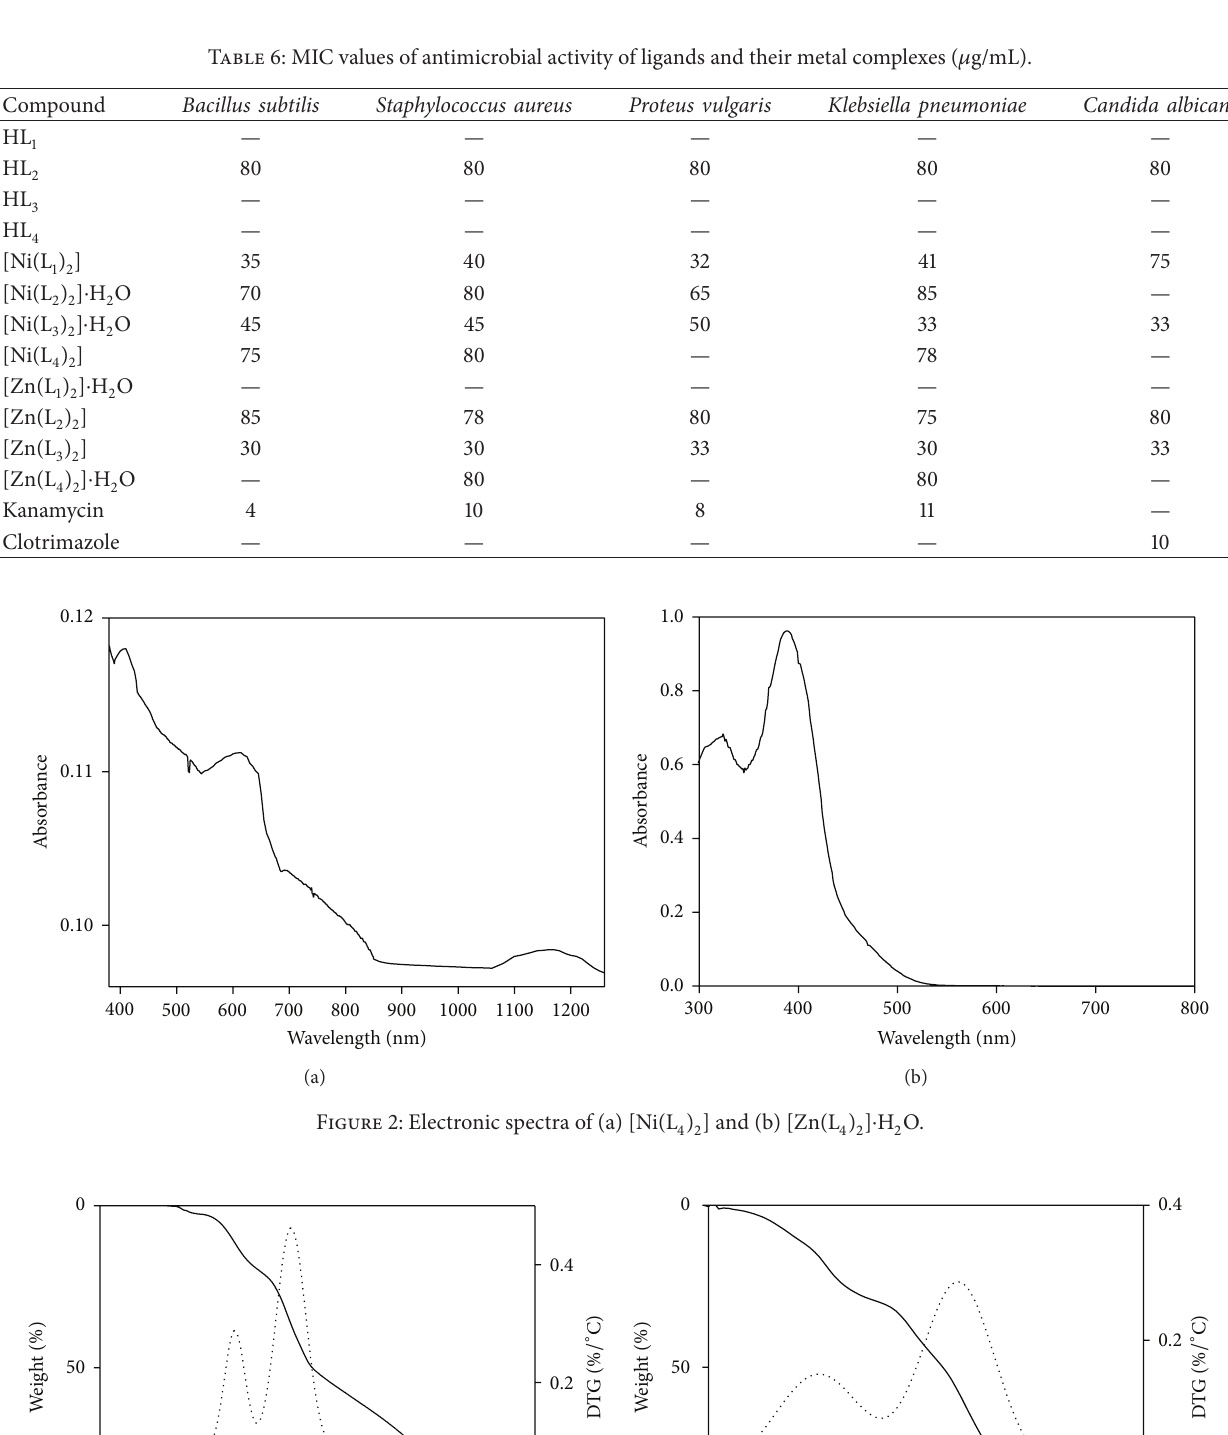
Table 6: MIC values of antimicrobial activity of ligands and their metal complexes ( 𝜇 g/mL). Compound Bacillus subtilis